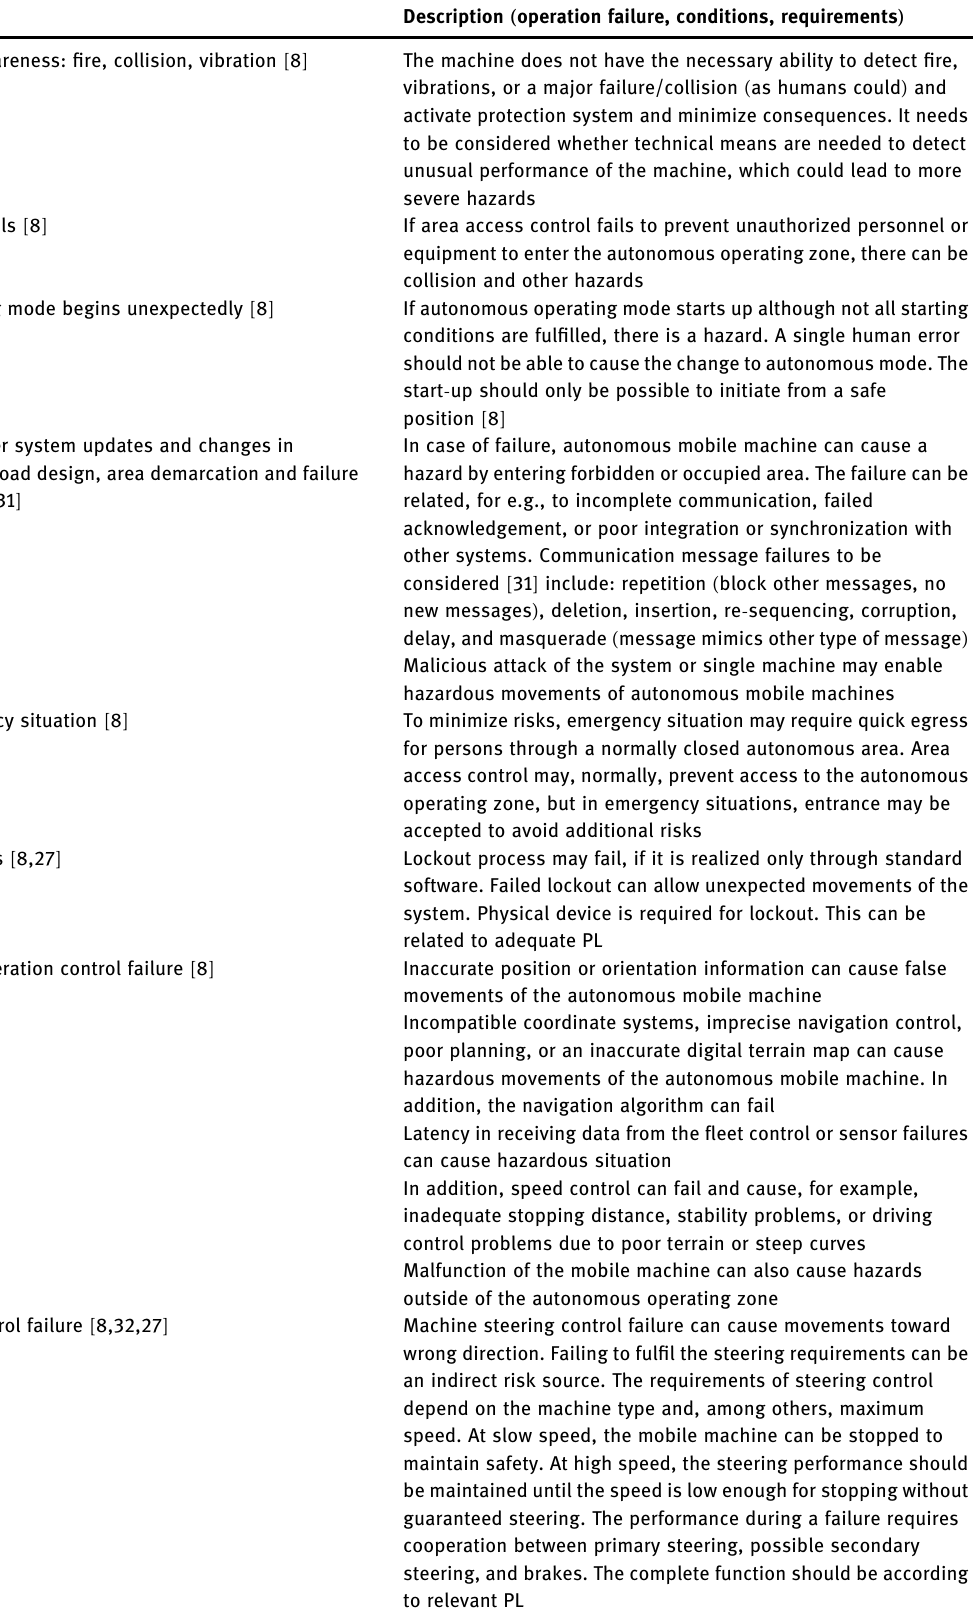
Table 2: Autonomous operation failures and related risk sources Risk